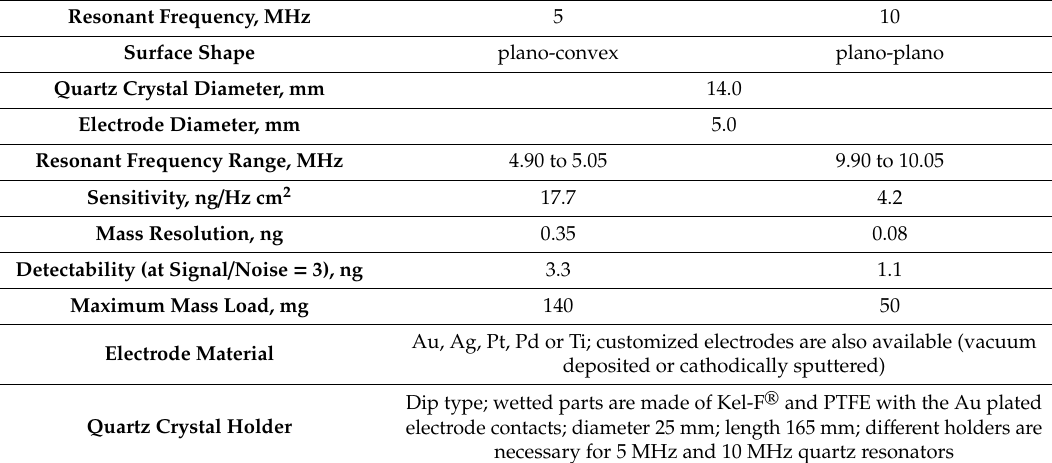
Figure 10. The analytical cell with holder equipped with quartz resonator. Table 2. Quartz crystal